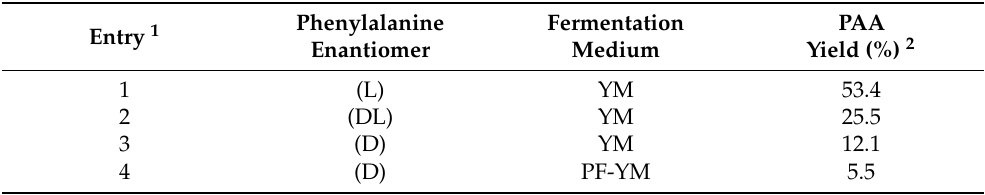
Table 5. Synthesis of phenylacetic acid by biotransformation of (L)-, (DL)-, and (D)-phenylalanine, using Yarrowia lipolytica (DSM 8218).